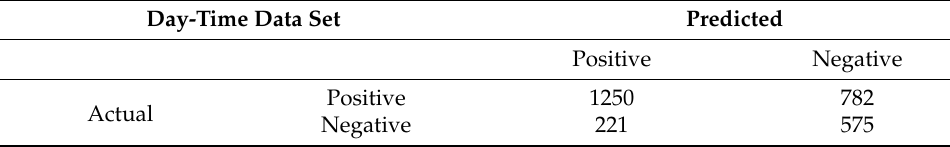
Figure 23. P-R curve of the sum of information obtained by the data set. Figure 23. P ‐ R curve of the sum of information obtained by the data set. Figure 23. P ‐ R curve of the sum of information obtained by the data set. Table 5. Confusion matrix of daytime in SiamRPN. Table 5. Confusion matrix of daytime in SiamRPN. Table 5. Confusion matrix of daytime in SiamRPN.